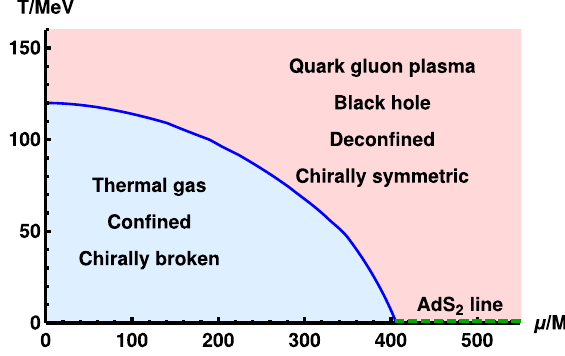
Fig. 10 The phase diagram for a set of potentials fitted to QCD data (potentials